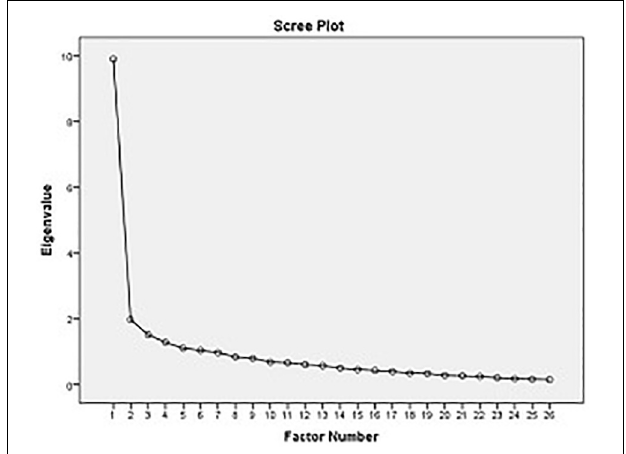
FIGURE 1 | Scree plot to determine the number of factors.